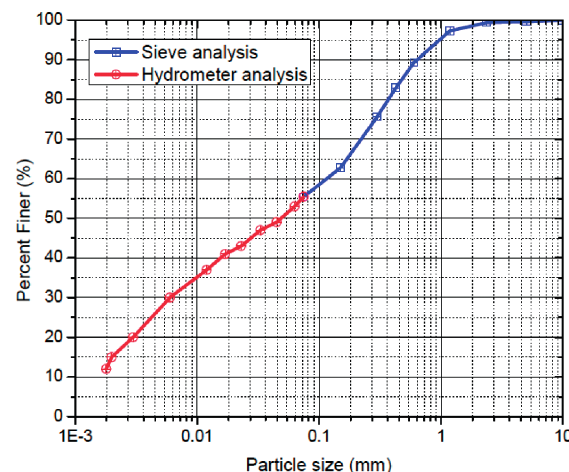
Fig. 3. Particle size distribution of tested soils